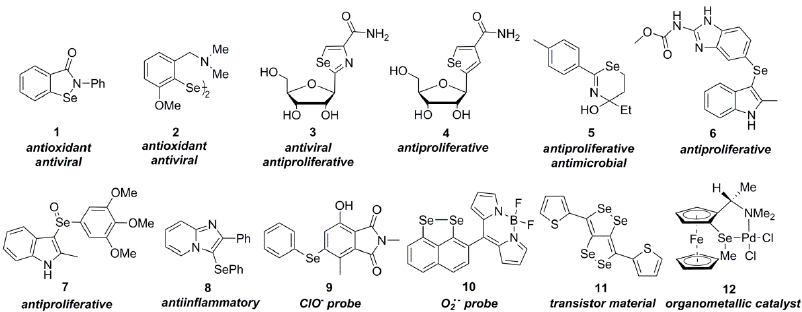
Figure 1. Representative organoselenium compounds.